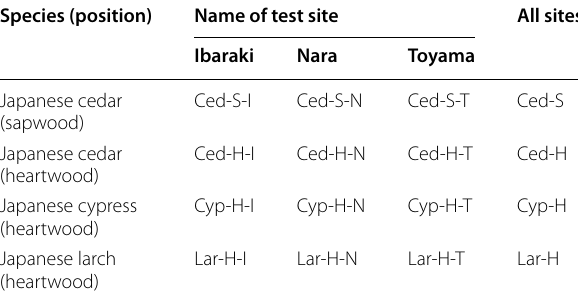
Table 2 Abbreviations used for each stake group